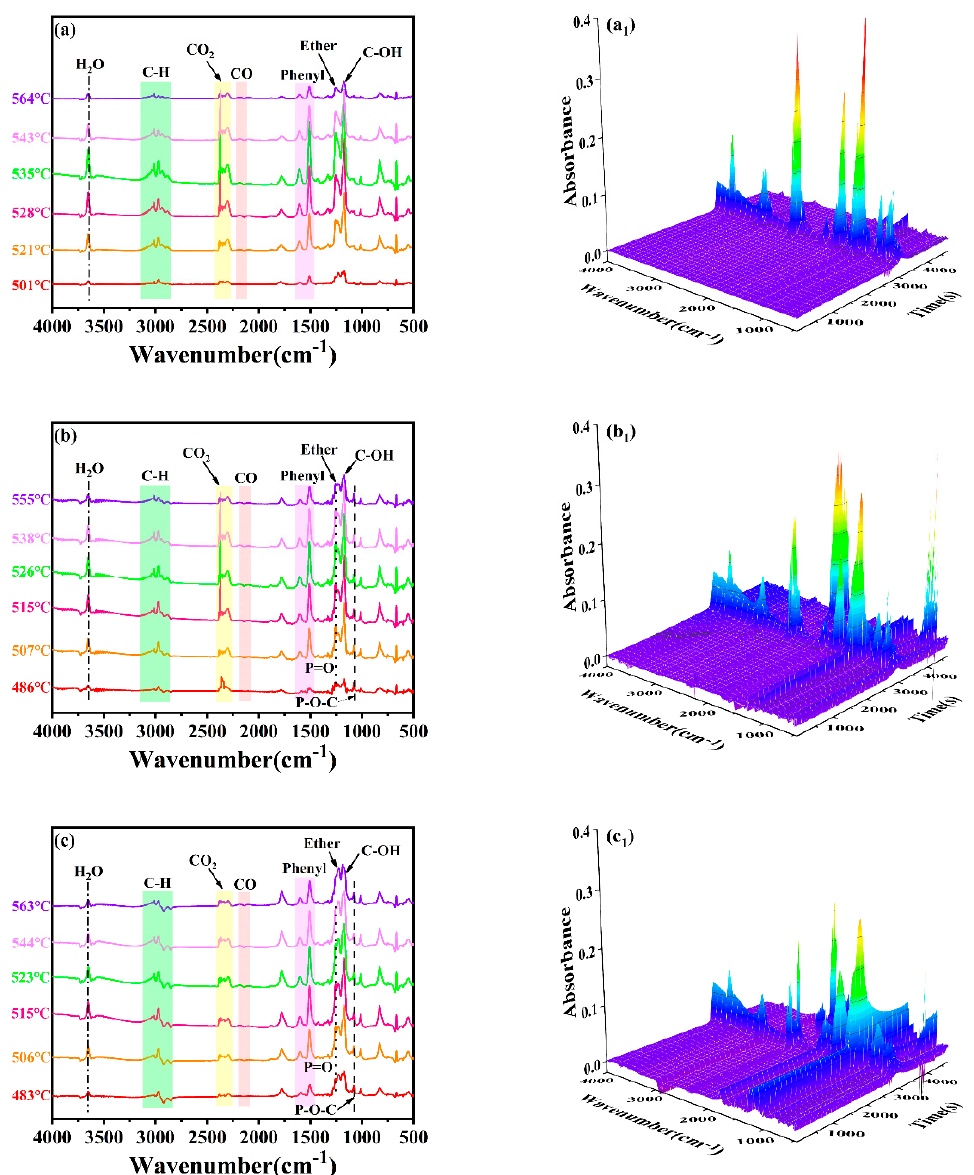
Figure 6. FTIR spectra of gaseous products at various temperatures under nitrogen and 3D images of PC ( a , a 1 ), FRPC-1 ( b , b 1 ), and FRPC-2 ( c , c 1 ). PC ( a , a 1 ), FRPC-1 ( b , b 1 ), and FRPC-2 ( c , c 1